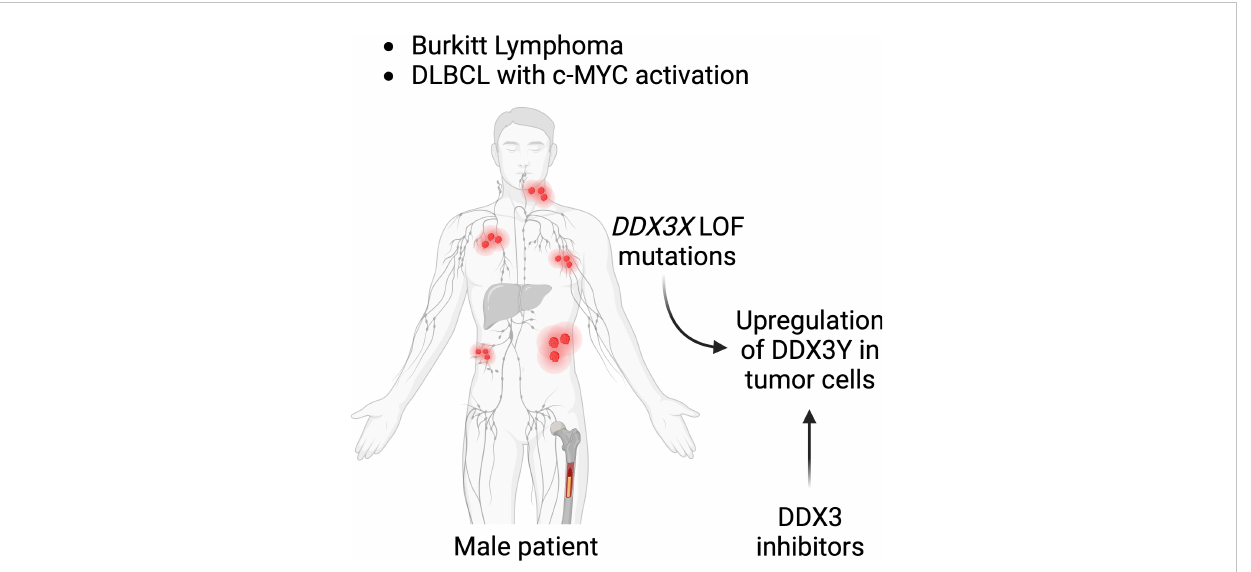
FIGURE 7 DDX3 as a target for lymphoma treatment. Male patients suffering from BL or subtypes of DLBCL with c-MYC activation who have mutations in their DDX3X gene, may be treated with DDX3 inhibitors. DDX3Y is not expressed in other human cells and DDX3Y aberrant protein expression speci fi cally seen in lymphoma cell could provide a tumor type speci fi c